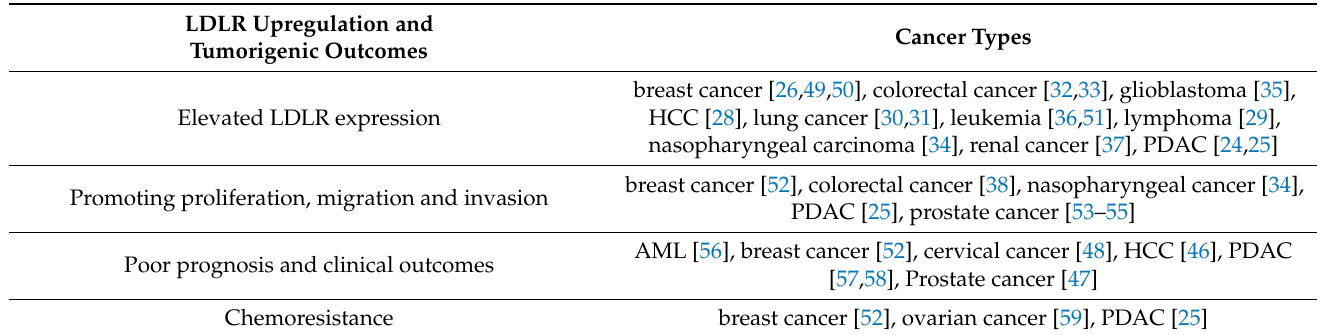
Table 1. Characteristics and roles of LDLR in